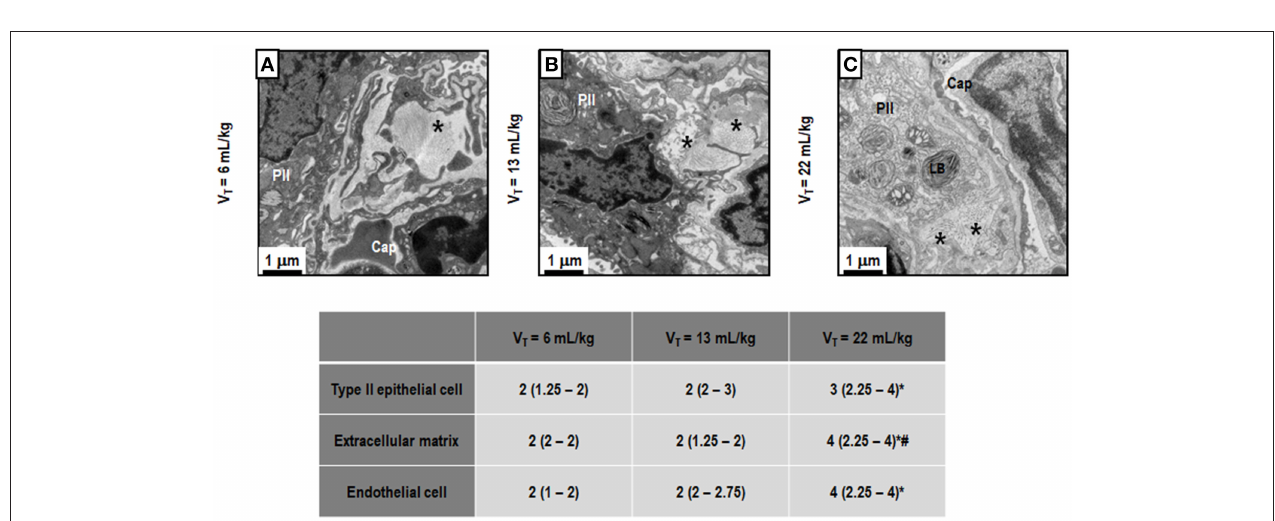
FIGURE 4 | Transmission electron microscopy of alveolar architecture. Photomicrographs are representative of data obtained from lung sections of 7 animals in each group. The following groups were analyzed: (1) V T = 6 mL/kg and RR adjusted to normocapnia (A) ; (2) V T = 13 mL/kg (B) ; (3) V T = 22 mL/kg (C). In the second and third groups, RR was adjusted to yield mechanical power comparable to that in the first group. Asterisk: extracellular matrix (ECM), PII: Type II epithelial cell, Cap: capillary, LB, lamellar body. PII damage is visible in all ARDS groups, regardless of tidal volume. LB decreased with increasing tidal volume. Moreover, the ECM was characterized by damage to collagen/elastic fibers (asterisk). Endothelial cells were less damaged at V T = 6 mL/kg and V T = 13 mL/kg. Semi-quantitative electron microscopy analysis of lung tissue. A five-point, semi-quantitative, severity-based scoring system was used: 0 = normal; or damage to 1 = 1–25%; 2 = 26–50%; 3 = 51–75%; and 4 = 76–100% of examined tissue. Values are median (interquartile range) of 7 animals/group. *vs. V T = 6 mL/kg ( p < 0.05); # vs. V T = 13 mL/kg ( p < 0.05).